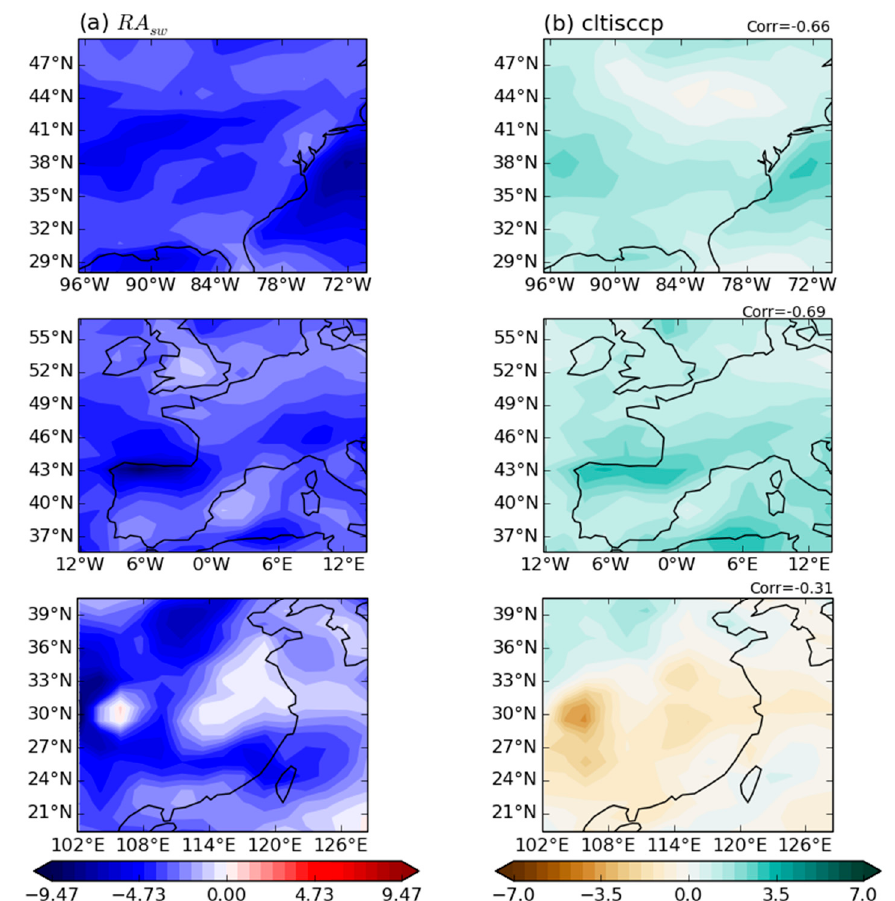
Figure 6. Regional (1st: EUS, 2nd: WEU, and 3rd: ECC) distributions of ( a ) the shortwave rapid adjustment (RAsw, W/m (cid:2870) ) and ( b ) the change in ISCCP total cloud fraction (cltisccp, %) from the pre-industrial (1850) to the T2 (1980–2010) period. Spatial correlation coefficients are shown in the upper right corner.